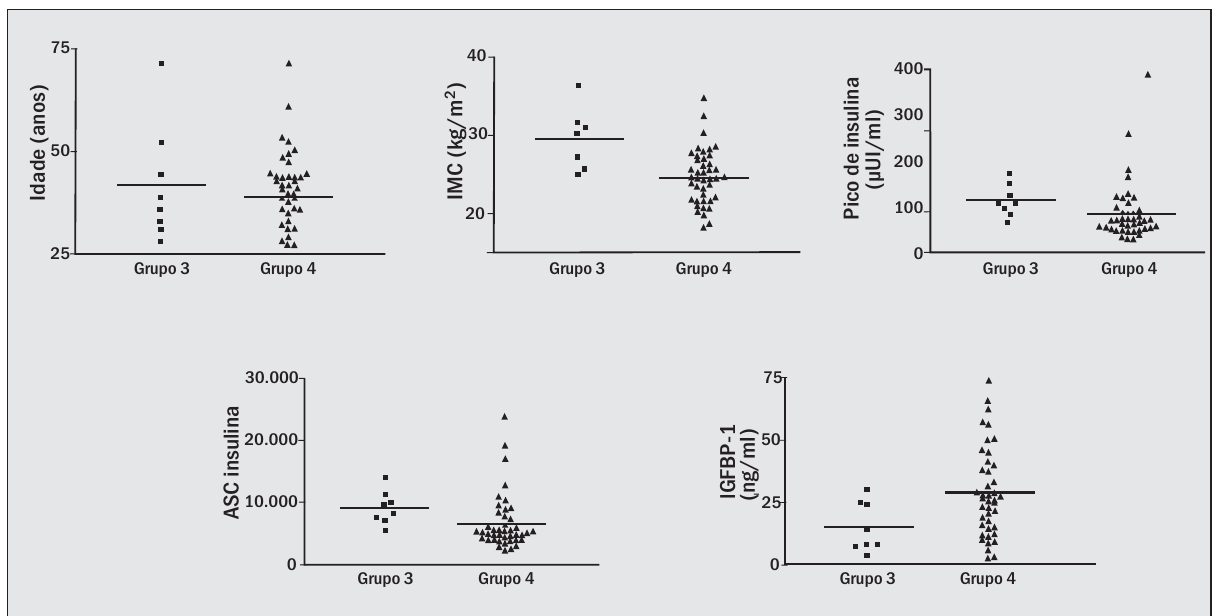
Figura 3 – Comparação entre idade (anos), IMC (kg/m 2 ), pico de insulina durante o oGTT ( (cid:181) UI/ml), área sob a curva de insulina durante o oGTT e concentrações séricas basais de IGFBP-1 (ng/mL) entre grupos de indivíduos normais pelos critérios da ADA e intolerantes pelos critérios da OMS/NDDG (grupo 3, n = 8) e indivíduos considerados normais pelos critérios da ADA e da OMS/NDDG (grupo 4, n =